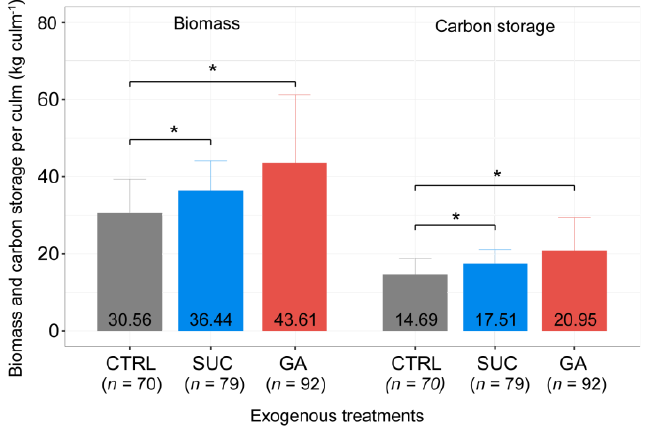
Figure 7. Comparison of the estimated biomass and carbon storage under different exogenous treatments. The numbers at the bottom of the bar graph represent the average values. The error bars show the 95% Bayesian credible intervals. The asterisk means a significant difference according to the Bayesian GLMM. The numbers in brackets represent the sample sizes.